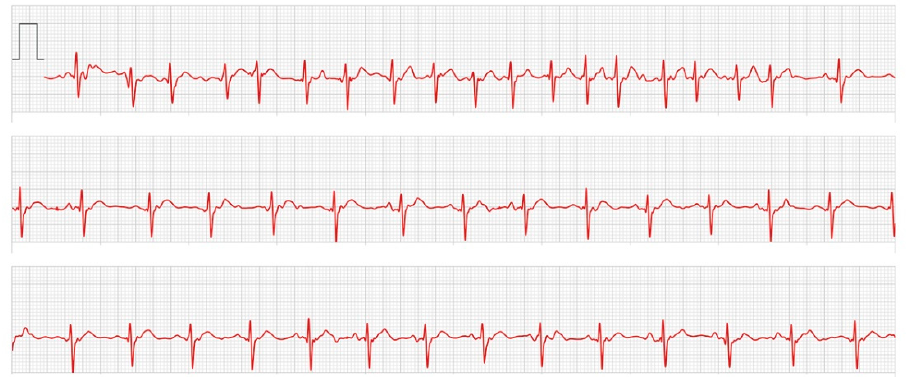
Figure 3. Paroxysmal atrial fibrillation was detected during the arrhythmic attack. Electrocardiogram that was collected during the second minute after notification of the tachycardic episode. 25 mm/s, 10 mm/mV, iOS v15.4.1, Apple Watch 4.2, algorithm ver.